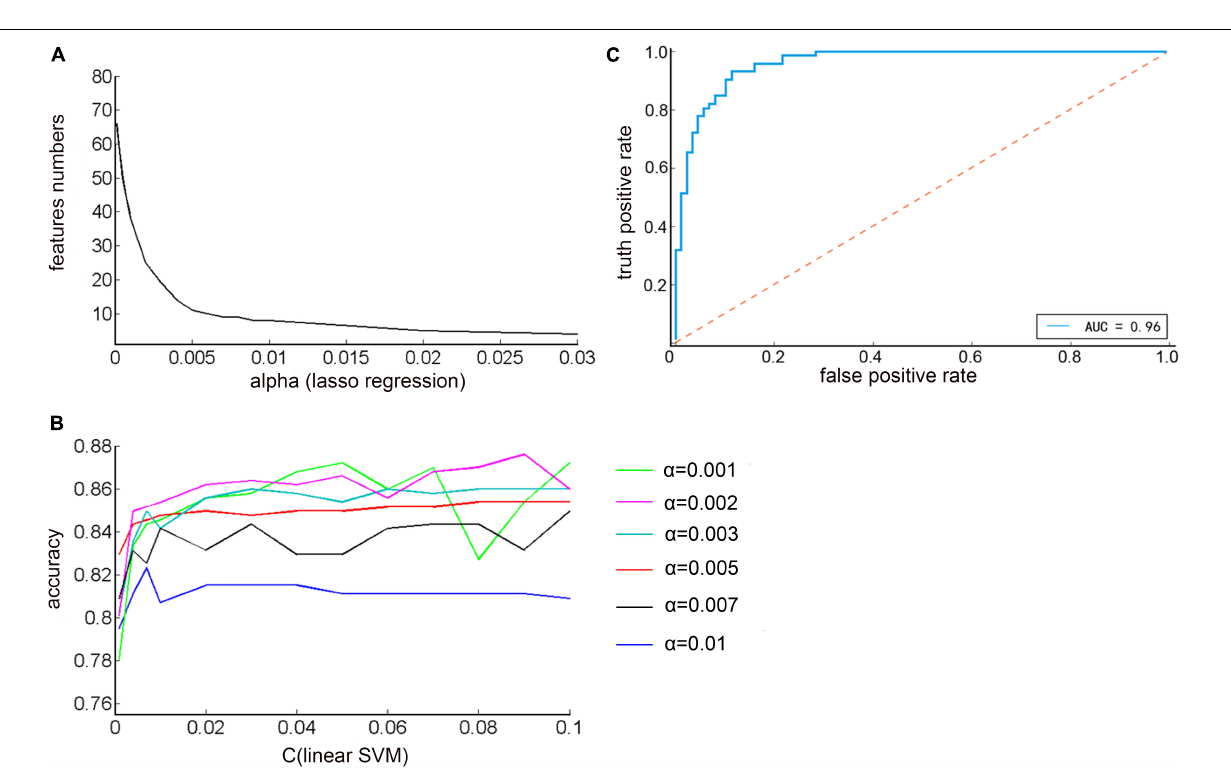
FIGURE 4 | (A) The relationship between the regularization parameter alpha of the Lasso regression algorithm and the number of feature selections (B) The relationship between the penalty coefficient C of the linear support vector machine and the correct rate of the prediction result under different alpha values (C) ROC curve of optimal classification